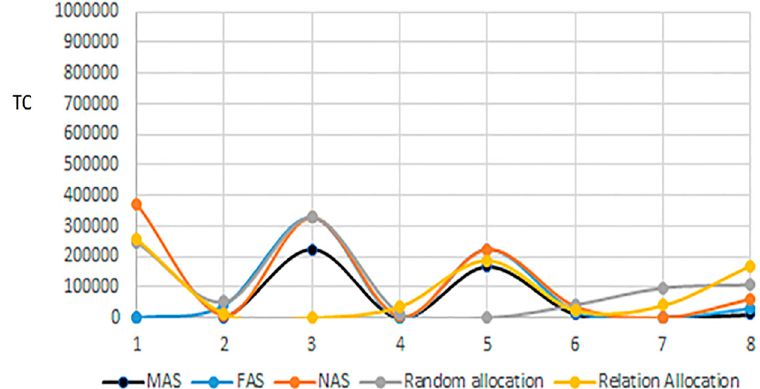
Figure 5. Problem 1, present work of this paper, transmission costs with site clustering of [7].